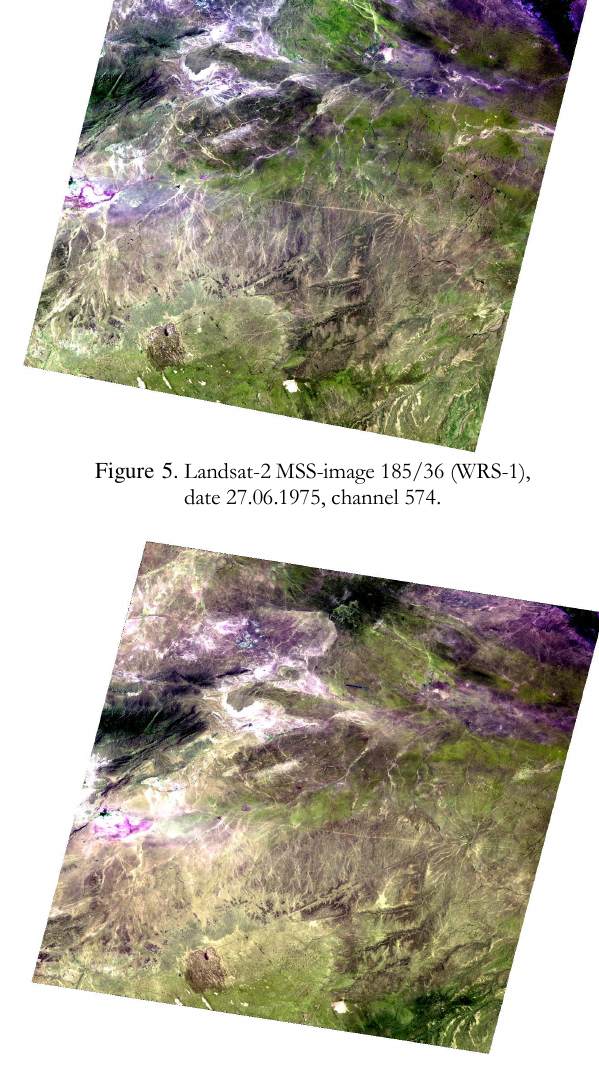
Figure 6. Landsat -4 MSS-image 172/36 (WRS-2), date 12.07.1983, channel